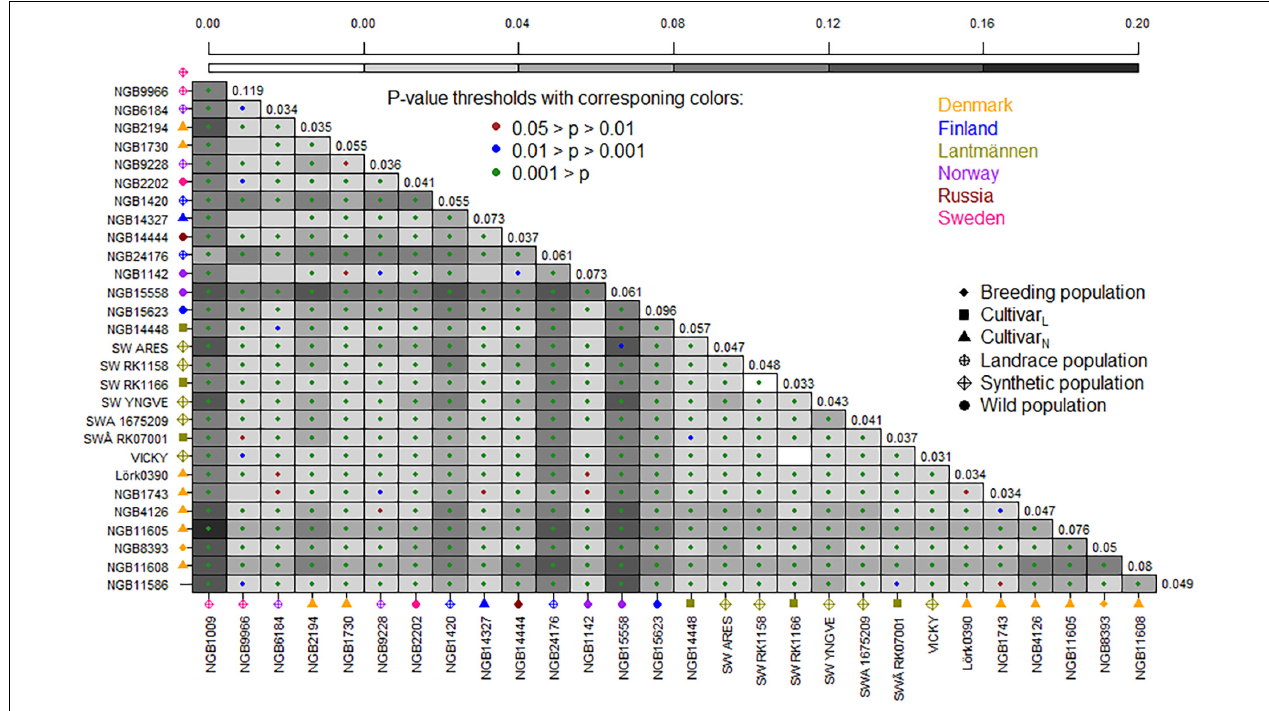
FIGURE 2 | A graphical illustration of pairwise F ST values between populations. The range of background color from light to dark corresponds to low to high F ST values. The color of a dot in each square indicates the level of significance with brown for 0.05 > p > 0.01, blue for 0.01 > p > 0.001 and green for p < 0.001. The average F ST values are given in the diagonal. The accessions are given on x- and y-axes, with corresponding label shape and color representing population type and country of origin, respectively (see figure keys). Cultivar L = cultivar from Lantmännen; Cultivar N = Cultivar from